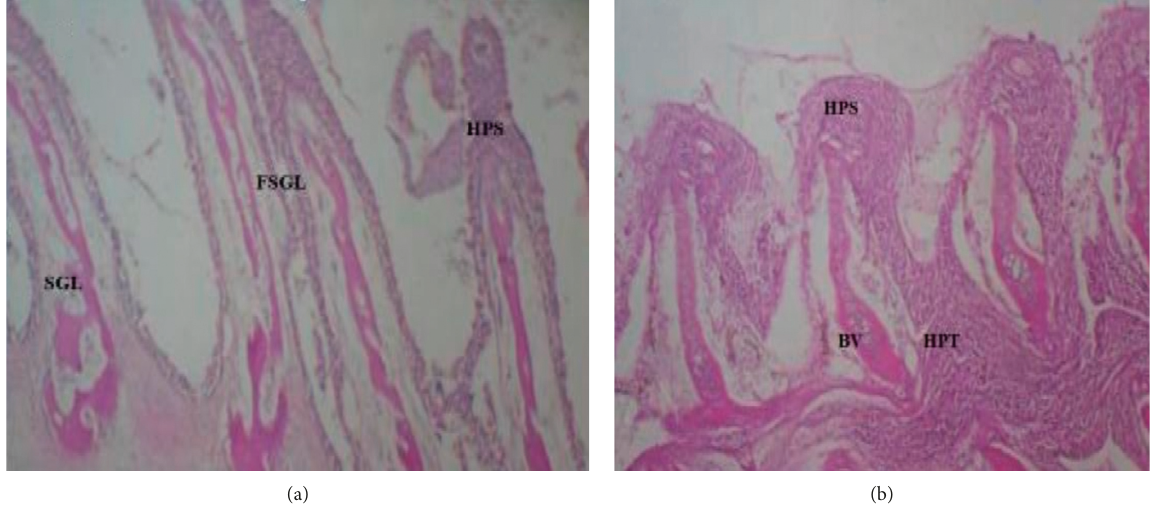
Figure 8: (a) Histological section of gill exposed to nano-SiO/CuO (2:1) showing fused secondary gill lamella (FSGL), secondary gill lamella (SGL), and epithelial hyperplasia (HPS) (H&E stains, × 400). (b) Histological section of gill exposed to bulk SiO/CuO (2:1) showing hypertrophy (HPT), blood vessel (BV), and epithelial hyperplasia (HPS) (H&E stains, ×